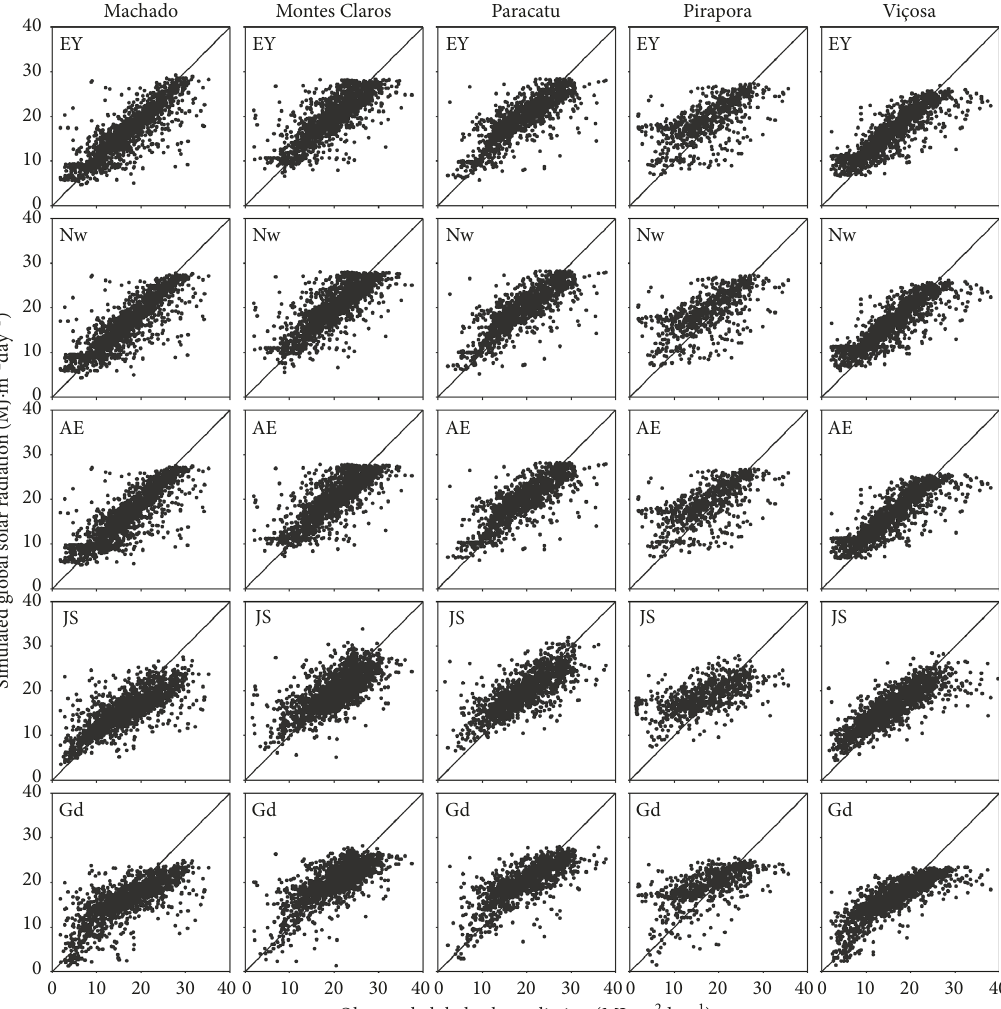
Figure 4: Simulated versus observed global solar radiation (MJ · m − 2 day − 1 ) for the five models that presented the best fit (EY: Ertekin and Yaldiz, 2000; Nw: Newland, 1989; AE: Akinoglu and Ecevit, 1990; JS: De Jong and Stewart, 1993; and Gd: Goodin et al., 1999) for Machado, Montes Claros, Paracatu, Pirapora, and Viçosa. The filled-in line refers to line